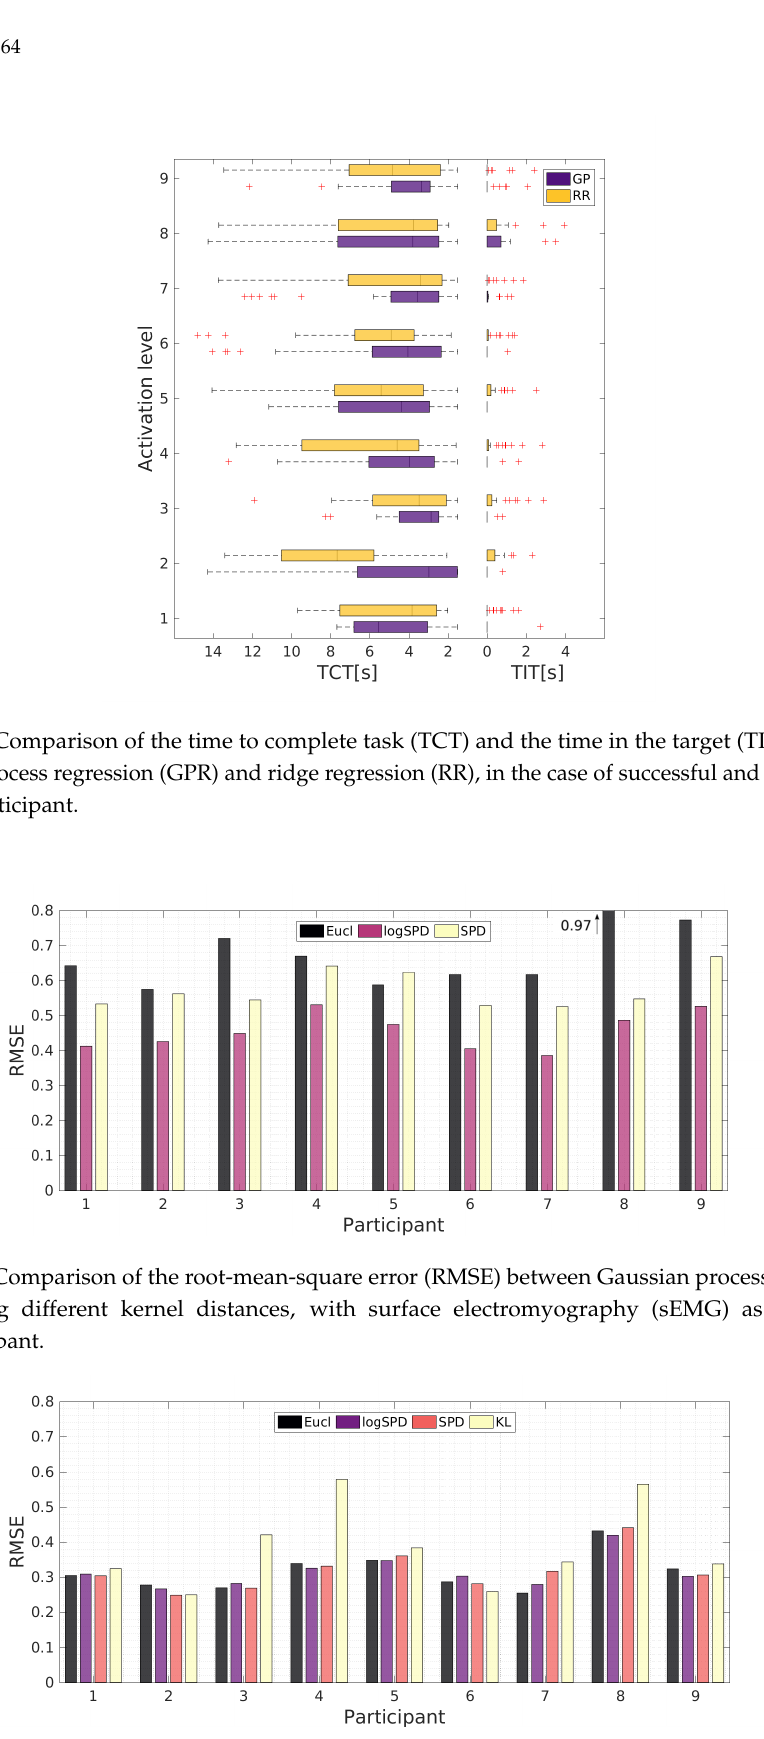
Figure A4. Comparison of the root-mean-square error (RMSE) between Gaussian process regression (GPR) using different kernel distances, with tactile myography (TMG) as input, for each